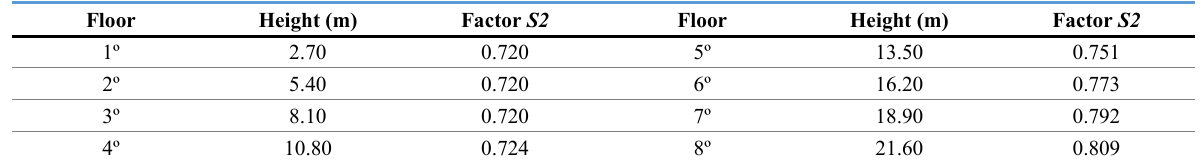
Table 1. Data for the calculation of wind forces [23].